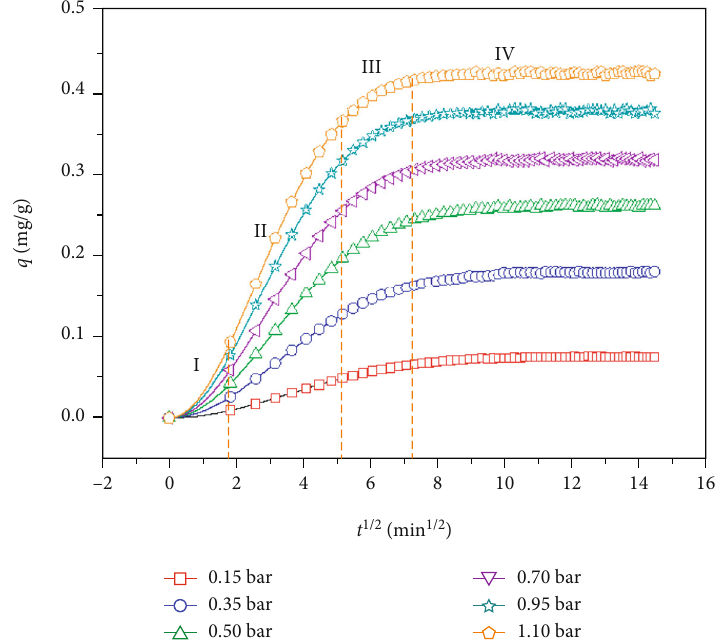
Figure 14: Prediction of intraparticle di ff usion model for HF adsorption on 3A.